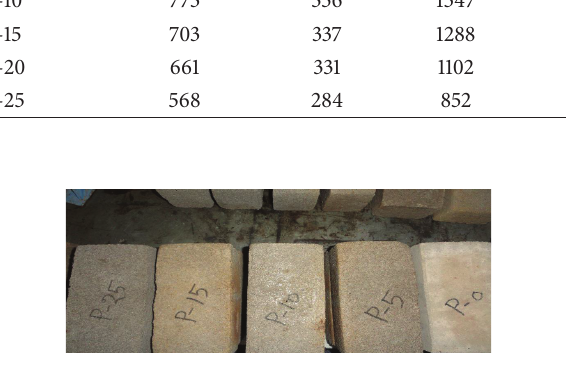
Figure 2: Appearance of brick